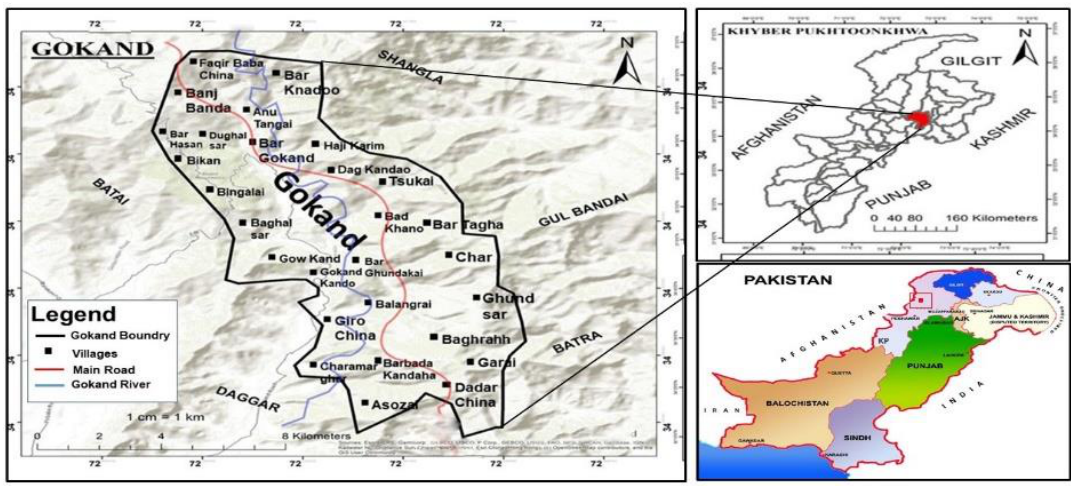
Figure 1. Map of the research area.